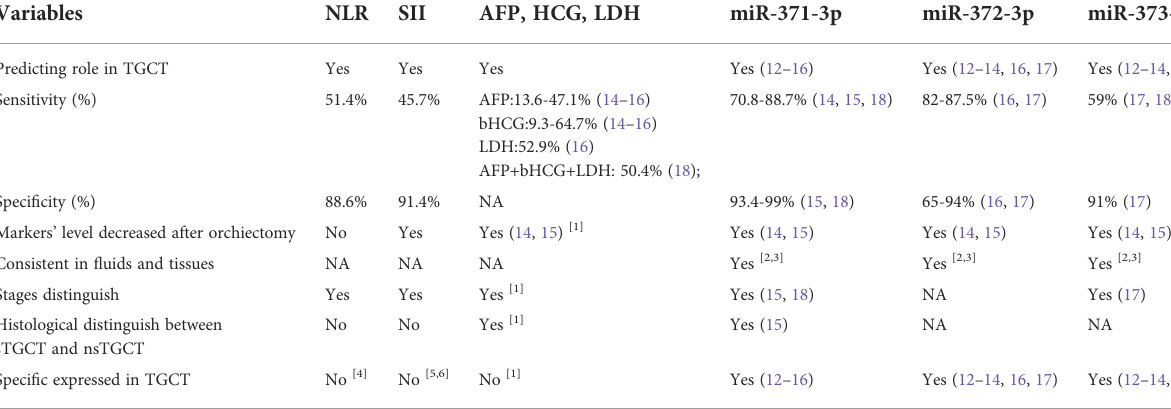
TABLE 7 Comparison of NLR, SII in present study with traditional biomarkers and miR markers reported by other studies.